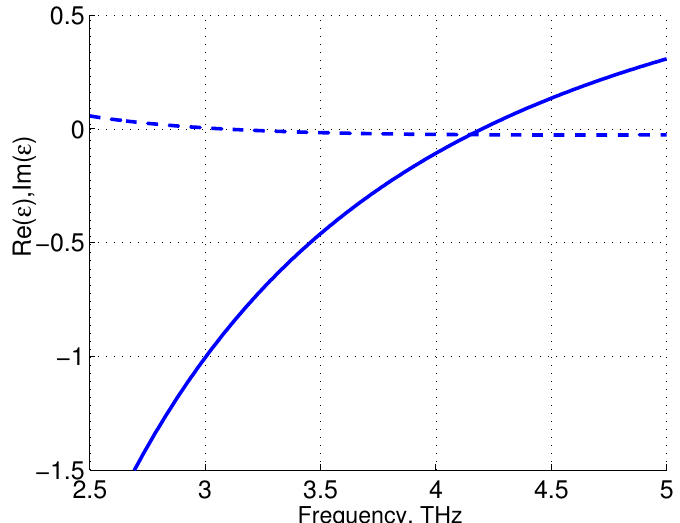
= 1 . 01 , d = 1 . 2 µ m, E h